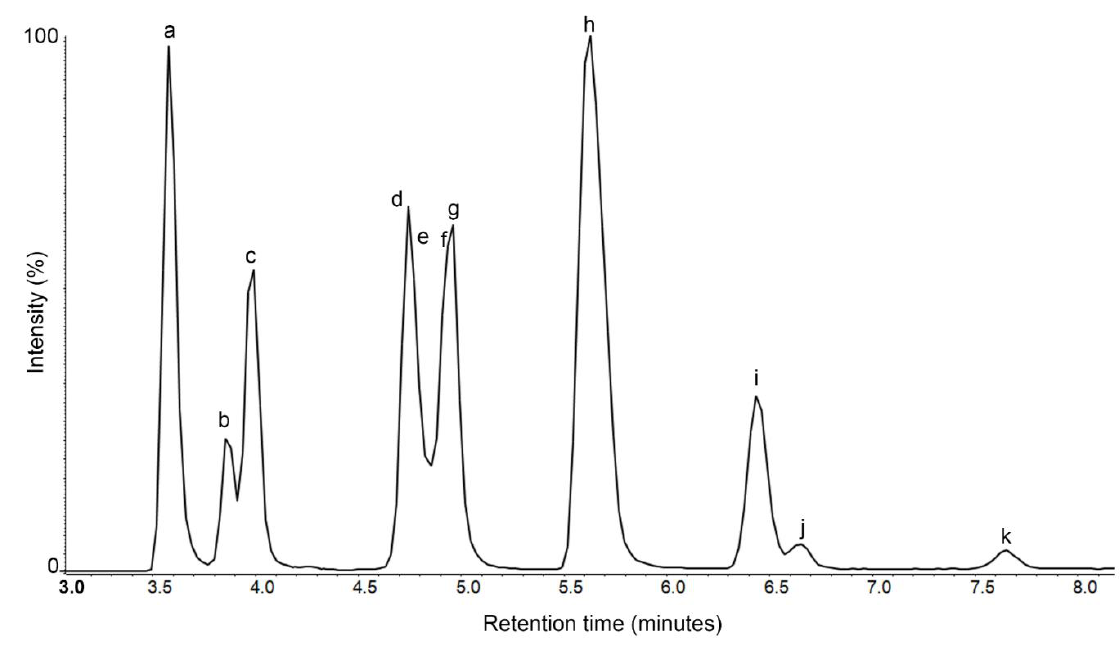
Figure 6. Reproduced from Chakrabarti, P.; Morré, J.T.; Lucas, H.M.; Maier, C.S. and Sagili, R.R. The omics approach to bee nutritional landscape. Metabolomics 2019 , 15 , 127, doi:10.1007/s11306-019-1590-6. The figure represents a total ion chromatograph of a representative sterol standard mix (75 μm). The sterol peaks identified are as follows: ( a ) desmosterol; ( b ) ergosterol; ( c ) 24-methylenecholesterol; ( d ) stigmasterol; ( e ) brassicasterol; ( f ) Δ 5 -avenasterol; ( g ) cholesterol; ( h ) campesterol; ( i ) β-sitosterol; ( j ) campestanol and ( k ) sitostanol.